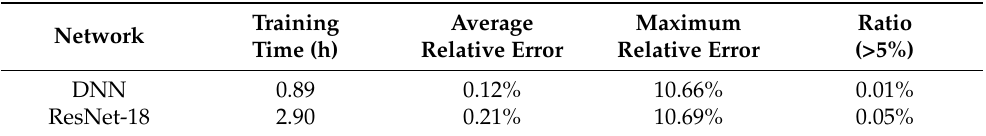
Table 5. The predictive performance of different neural networks on the coupling capacitance (the relative error is only evaluated for coupling capacitances greater than 1% of the corresponding total